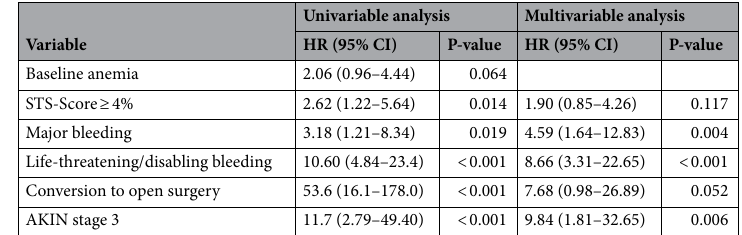
Table 4. Cox regression analysis. Results are presented as adjusted hazard ratios (HR) with 95% confidence intervals (CI). A p-value of < 0.05 was considered statistically significant. AKIN acute kidney injury network, CAR CRP/albumin ratio, STS-Score Society of Thoracic Surgeons risk